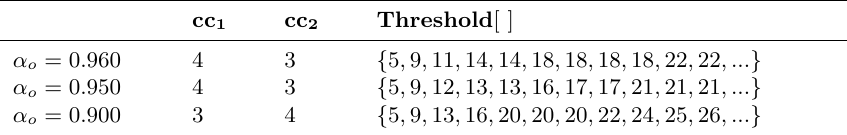
Table 5: The precomputed parameters for α o = 0 . 960, 0.950, and 0.900 cc